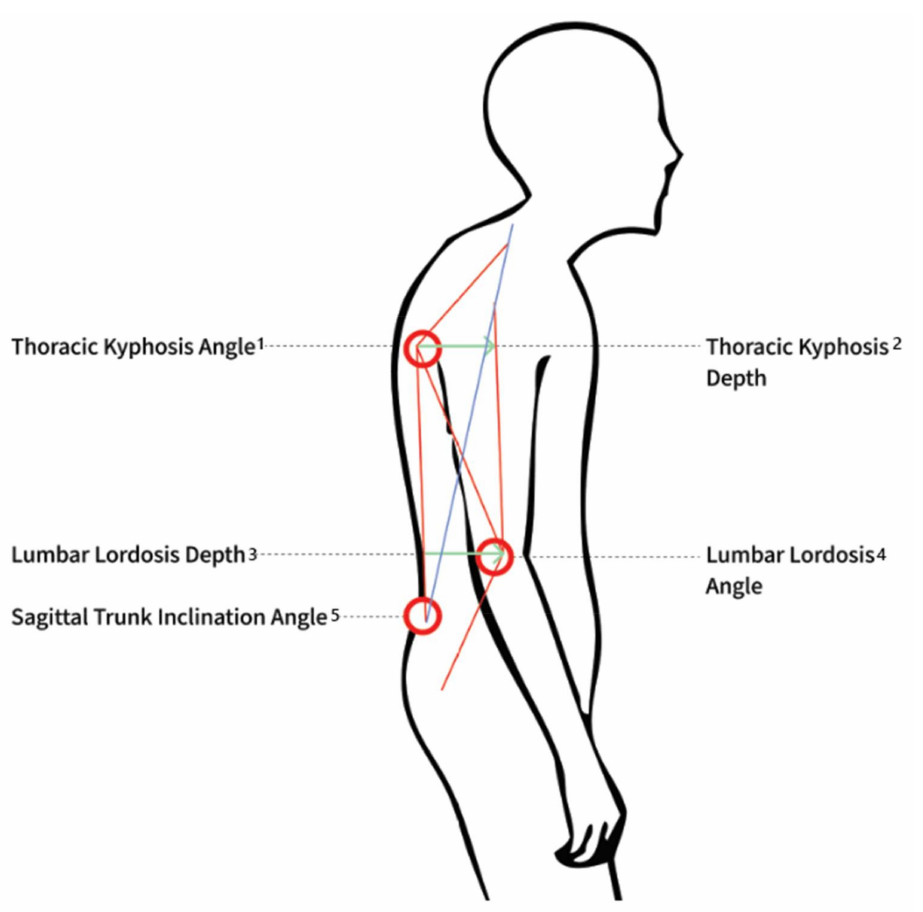
Figure 2. Summary of the main findings: (1) Found in three studies [39,42], named “Thorax” in [40]; (2) Found in three studies [38,42] and [39]; (3) Found in two studies [39,42]; (4) Found in three studies [39,42], named “Waist” in [40]; (5) Found in two studies [39,42]. Bold circles represent angles; green arrows represent depths, measured as sizes, not